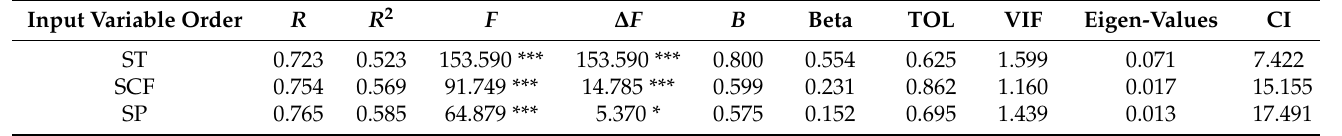
Table 2. The stepwise multiple regression analysis coefficients of the five dimensions of